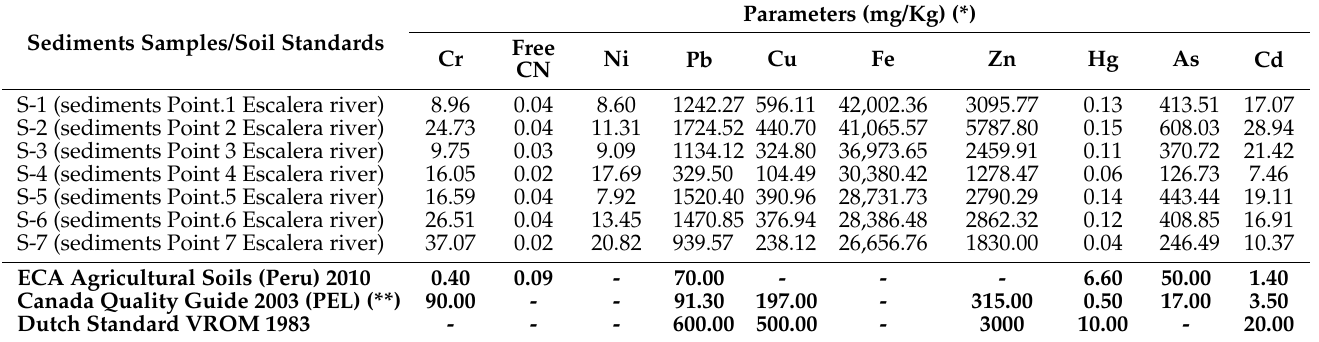
Sediments Samples/Soil